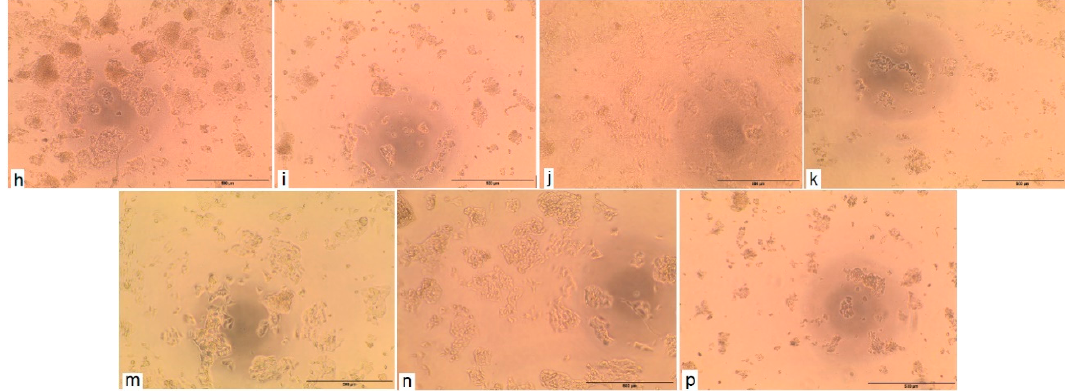
Figure 3. Cytotoxic activity against HePG2 cell line. ( h ): HePG2- E. oil —12.5 µg / mL. ( i ): HePG2- E. oil —25 µg / mL. ( j ): HePG2- E. oil —50 µg / mL. ( k ): HePG2- E. oil —100 µg / mL. ( m ): HePG2 control before treatment. ( n ): HePG2—DMSO at 100 ppm. ( p ): HePG2—positive (Doxorubicin) at 100 µg/mL.